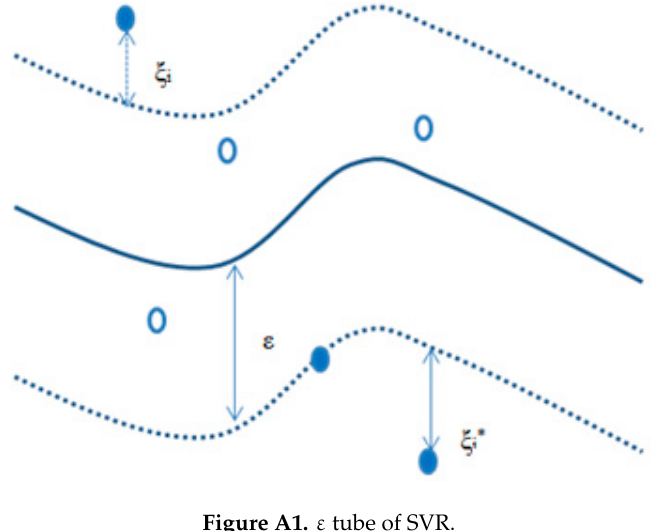
Figure A1. ε tube of SVR.